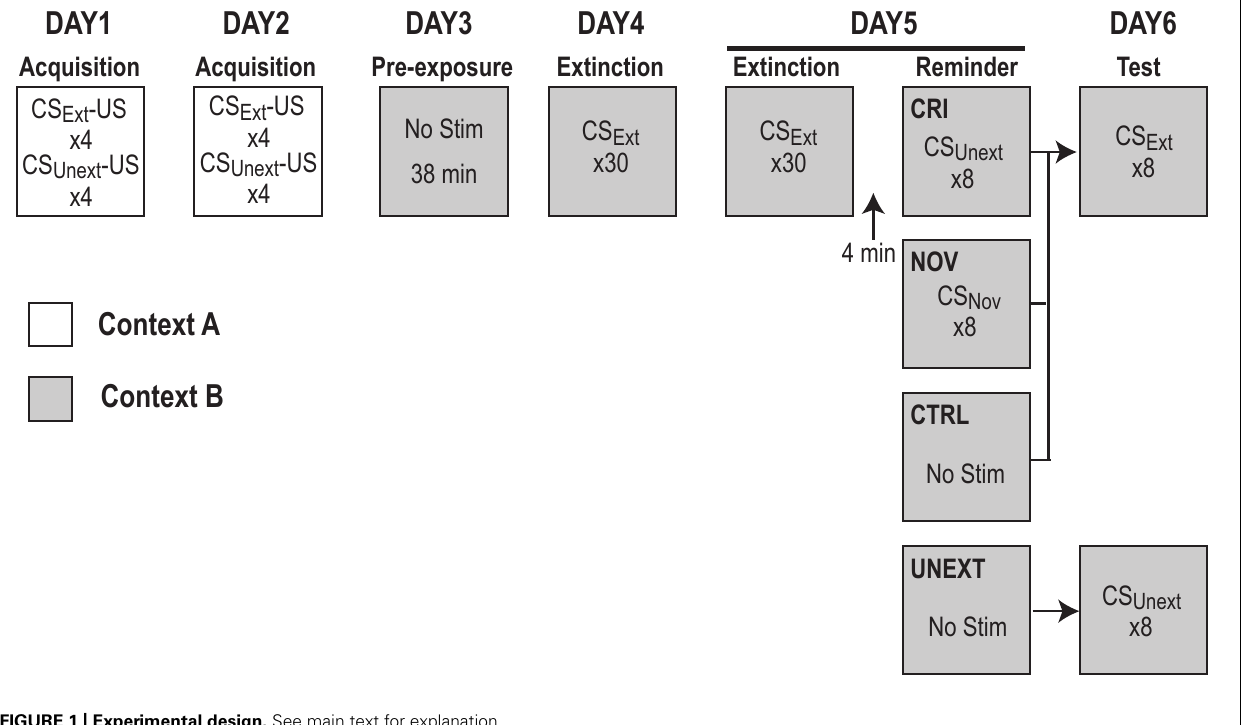
FIGURE 1 | Experimental design. See main text for explanation.